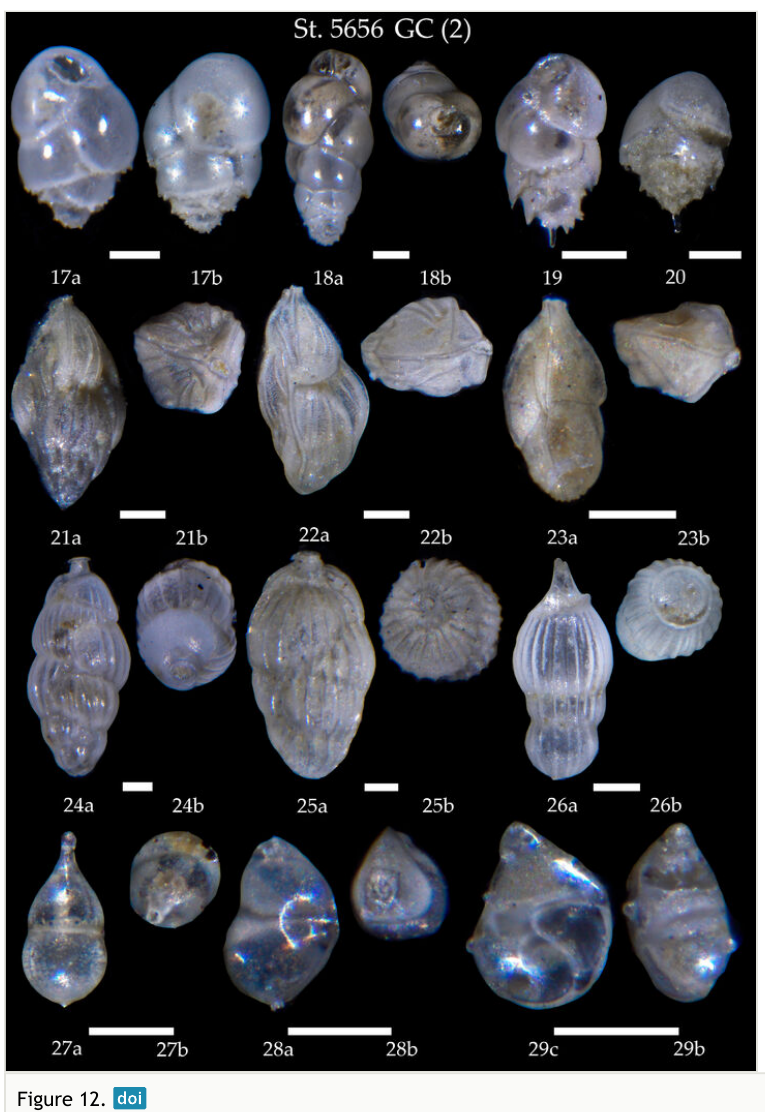
Figure 12. Station 5656 GC (continued). 17 Bulimina marginata , a side view, b apertural view; 18 Bulimina elongata , a side view, b apertural view; 19 Bulimina aculeata , a side view, b apertural view; 20 Bulimina aculeata , a side view, b apertural view; 21 Trifarina angulosa , a side view, b apertural view; 22 Trifarina fluens , a side view, b apertural view; 23 Trifarina bradyi , a side view, b apertural view; 24 Uvigerina peregrina , a side view, b apertural view; 25 Uvigerina mediterranea , a side view, b apertural view; 26 Amphicoryna scalaris , a side view, b apertural view; 27 Amphicoryna separans , a side view, b apertural view; 28 Neolenticulina variabilis , a side view, b apertural view; 29 Lenticulina gibba , a side view, b apertural view. Scale 100